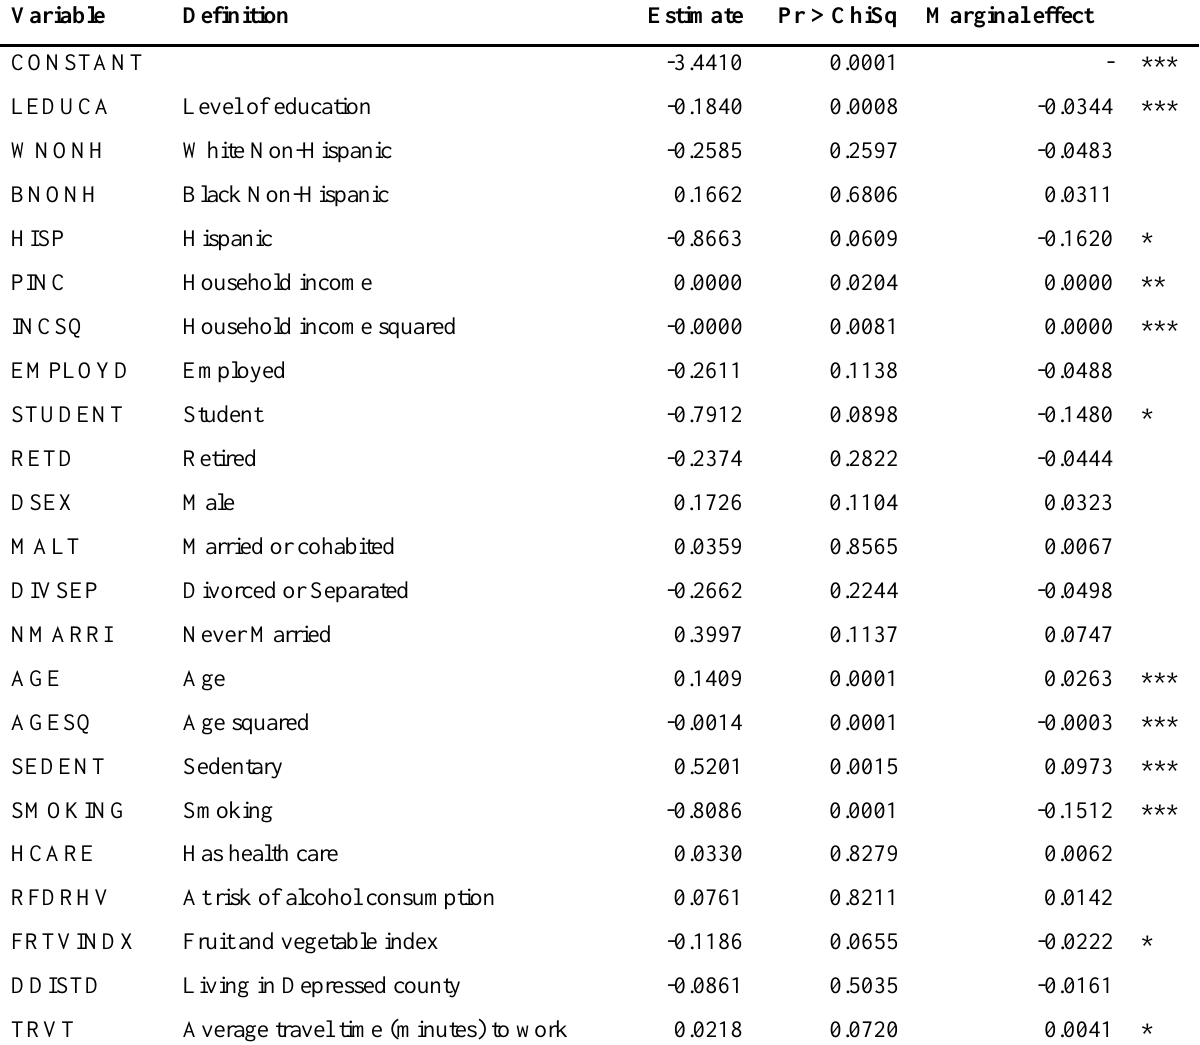
Table 3. Maximum likelihood logit estimates of obesity risk and associated marginal probabilities